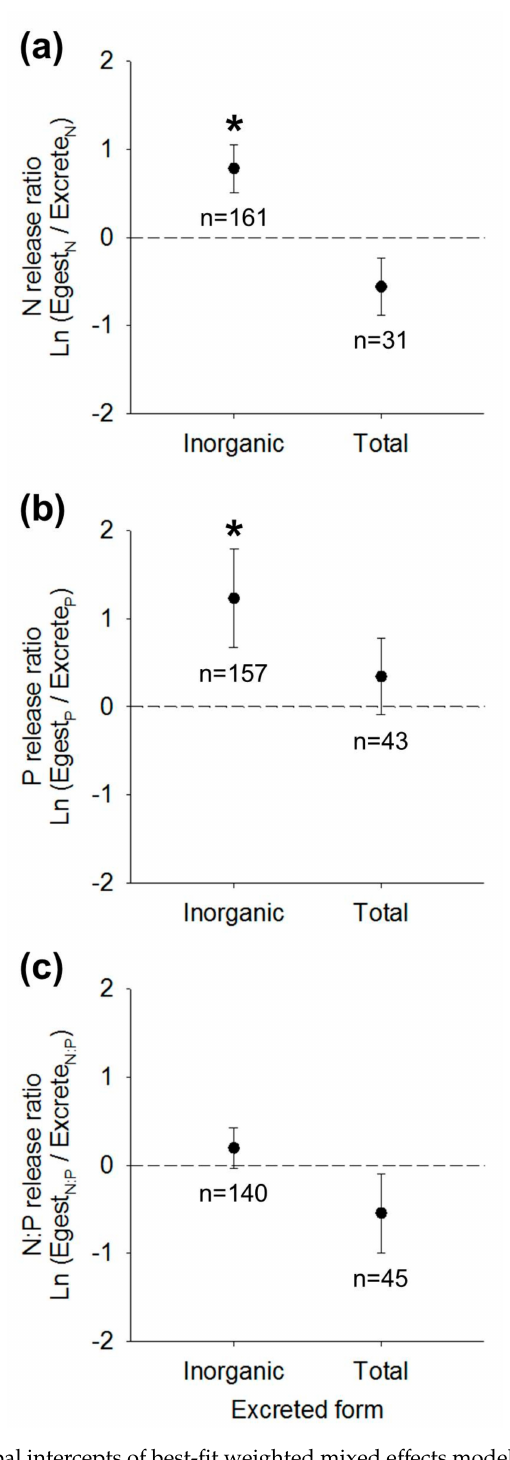
Figure 1. Mean ± SE global intercepts of best-fit weighted mixed e ff ects models predicting ( a ) N release ratios, ( b ) P release ratios, or ( c ) N:P release ratios of egestion compared to excretion. In each panel, means describe release ratios calculated from total nutrient egestion rates relative to (left) strictly inorganic nutrient excretion or (right) total nutrient excretion. Positive values indicate egestion rates or ratios exceed excretion rates or ratios. Sample sizes n (number of study populations) are designated for each mean and asterisks designate mean intercepts significantly di ff erent from zero (two-tailed t -test; p < 0.05). See Table 2 and Table S1 for associated model